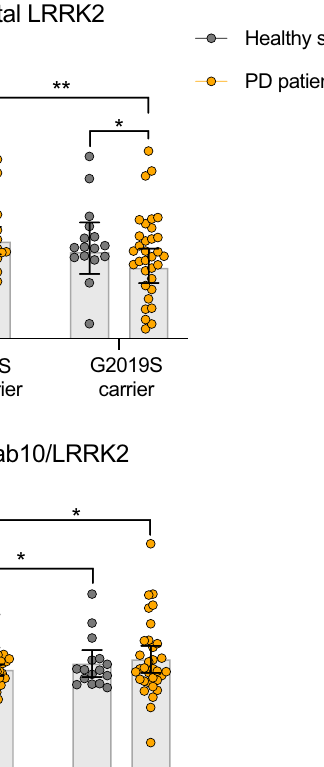
pS935 LRRK2 and total LRRK2 levels were reduced in subjects with PD carrying the G2019S variant compared to sporadic PD patients and healthy LRRK2 G2019S carriers (Fig. 5A,B and Supplementary Figure S8). This same sample set has been recently analyzed for total and pS935 LRRK2 levels via an orthogonal and analyti- cally validated assay, with substantially similar results, as well as via a sandwich ELISA-based assay with a noted non-significant trend toward reduced pS935 LRRK2 normalized to total LRRK2 levels, providing independent validation of these results 31,32 . pT73 Rab10 levels were not significantly different in any group, but when normal- ized for variations in total LRRK2 levels, we observed a significant elevation in LRRK2 G2019S carriers with PD compared to sporadic PD patients and in healthy LRRK2 G2019S carriers compared to non-carriers (Fig. 5C,D; Supplementary Table 3). Further, there was a non-significant trend toward increased pT73 Rab10 normalized to total LRRK2 in sporadic PD patients compared to healthy subjects (Fig. 5D). These data support that LRRK2 G2019S carriers with PD have elevated LRRK2 kinase activity that can be measured in a clinical setting.